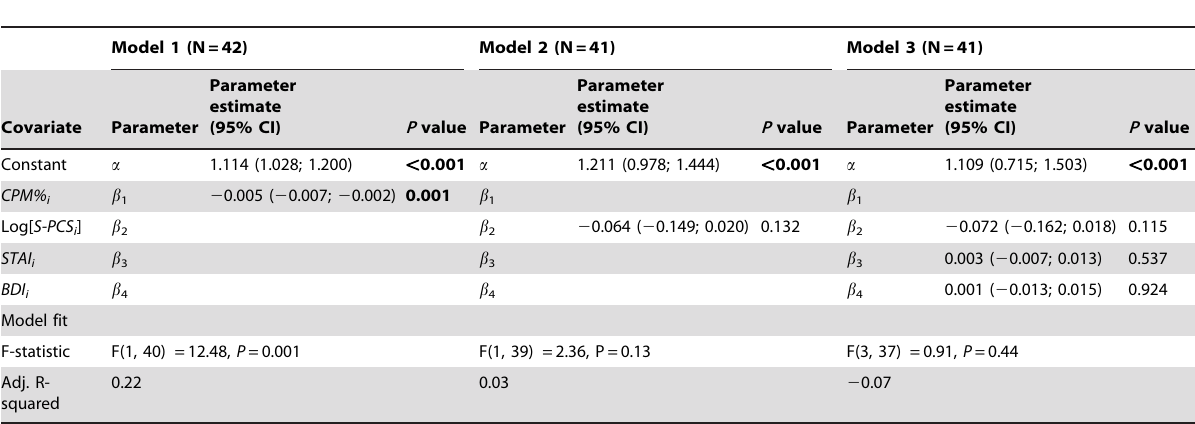
Table 4. Parameter Estimates from Regression Models of Postoperative Consumption of Morphine Equivalents (mg/kg/day) against Conditioned Pain Modulation, Situational Pain Catastrophizing, Anxiety, and